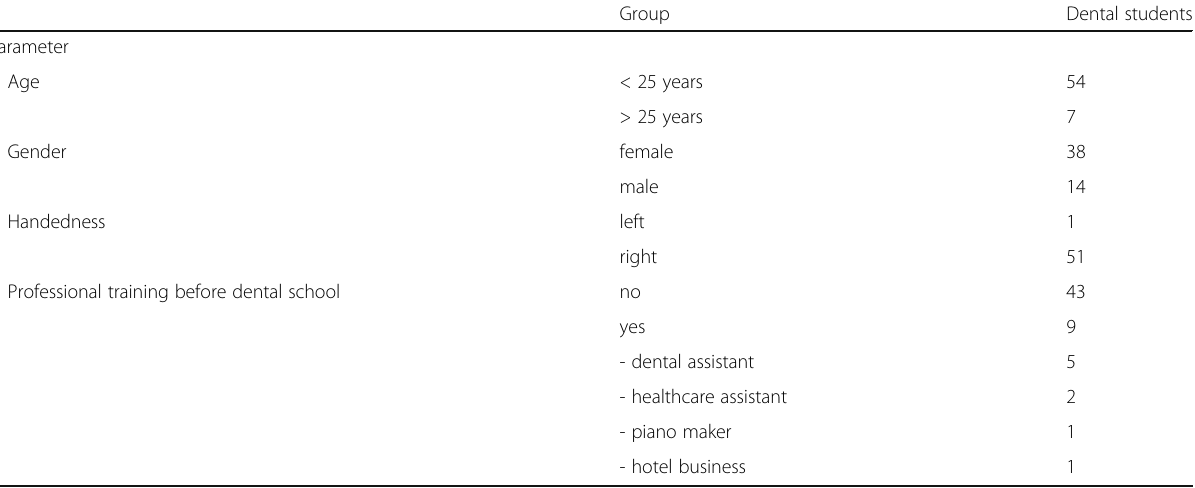
Table 1 Demographical data of the participants giving an overview about the distribution of age, sex, handedness and